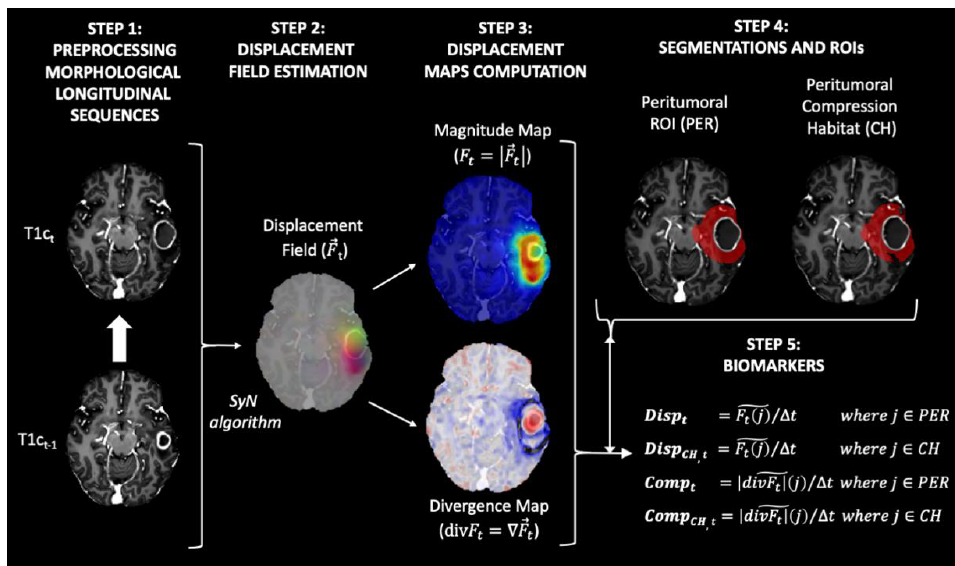
Figure 1. Diagram of the proposed method for obtaining the biomarkers proposed in our study. All maps and masks were superimposed on the T1-weighted contrast-enhanced image obtained at time t, with the exception of the maps in Step 3. In this step, the T1-weighted contrast-enhanced image obtained at time t − 1 was used to improve